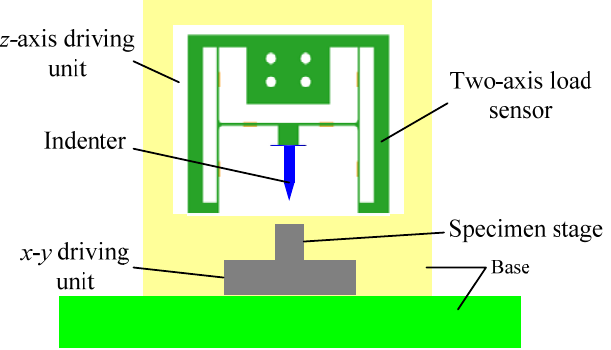
Figure 10. Schematic diagram for the application of conventional scratch